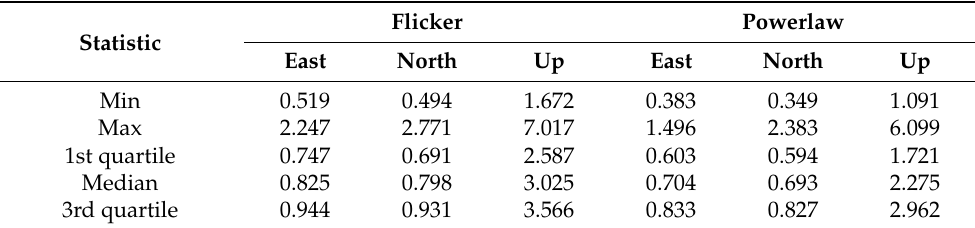
Table 3. Statistics of uncertainties for Flicker and Powerlaw noise in mm/year.